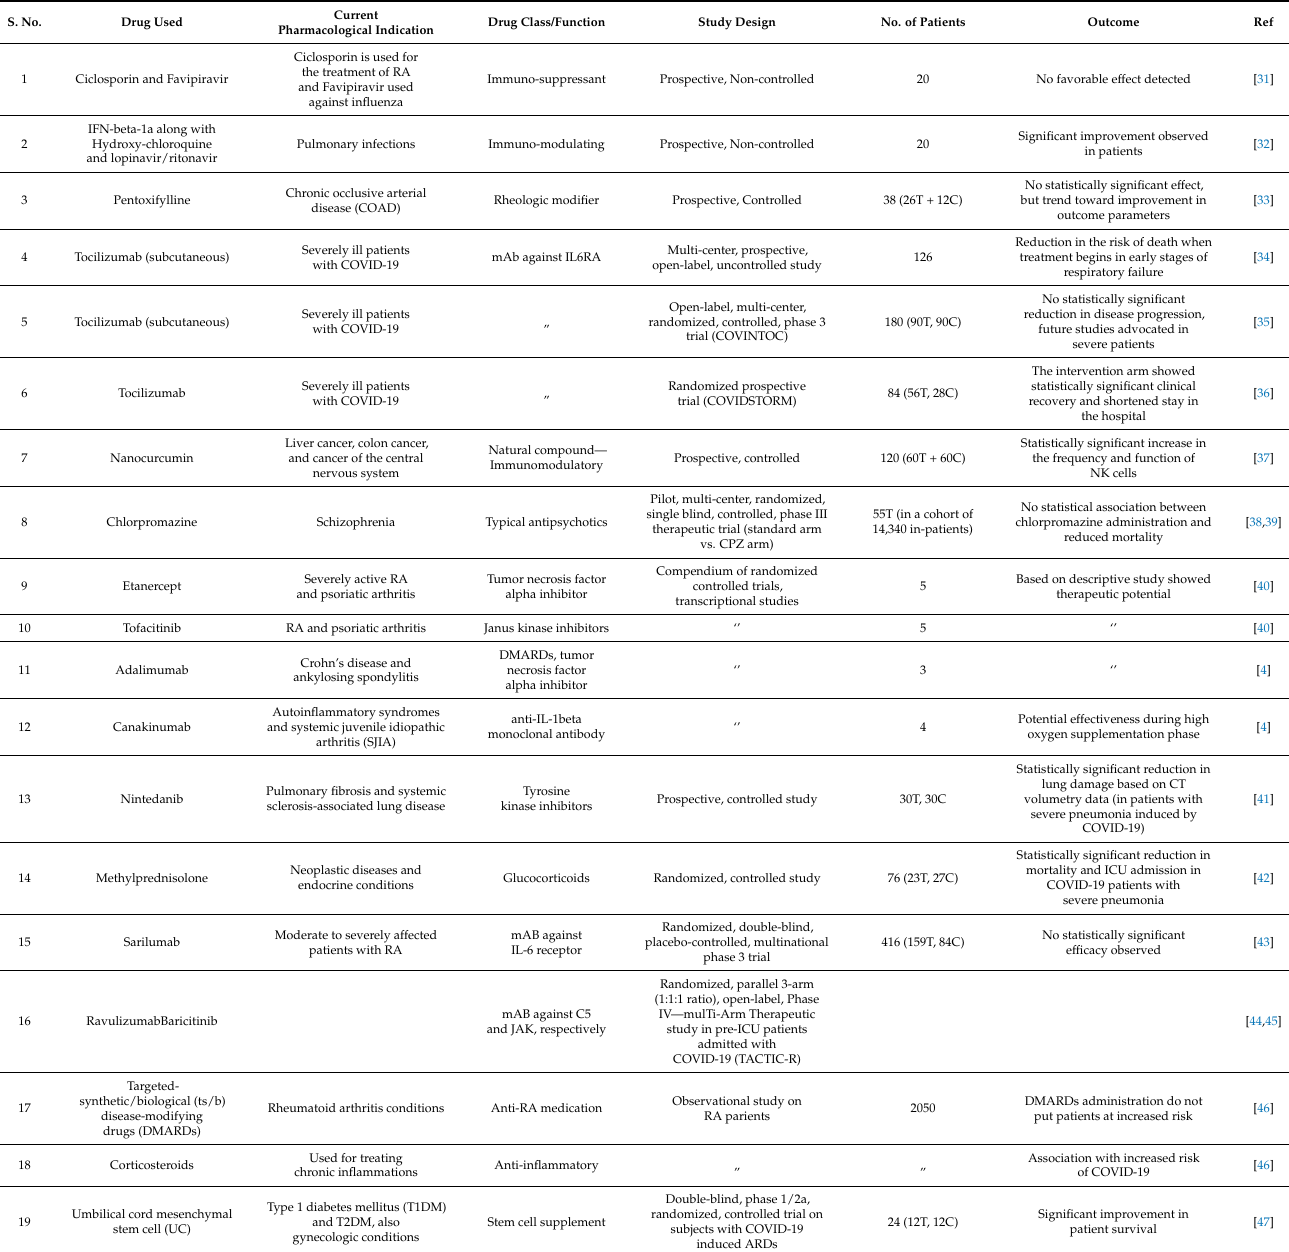
Table 1. List of immunomodulatory drugs/compounds clinically studied against COVID-19 disease.